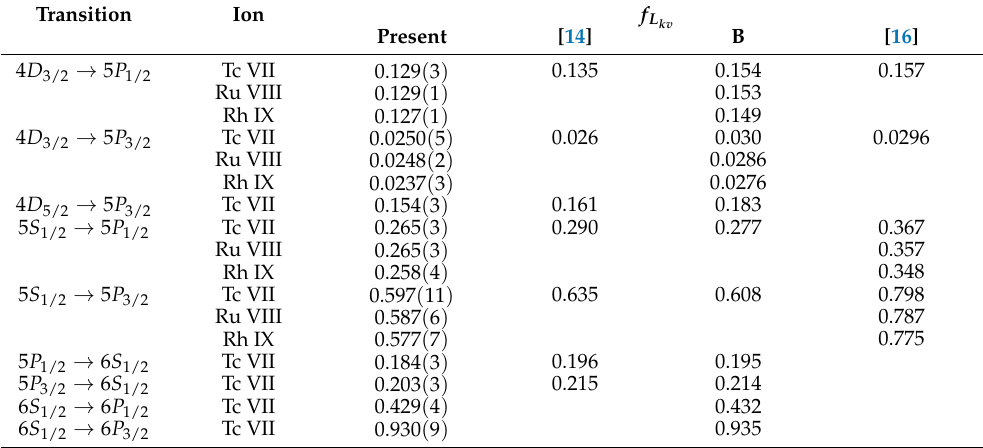
Table 5. Comparison of the oscillator strengths for Tc VII, Ru VIII and Rh IX ions from our calculations with available theoretical data. Uncertainties are given in